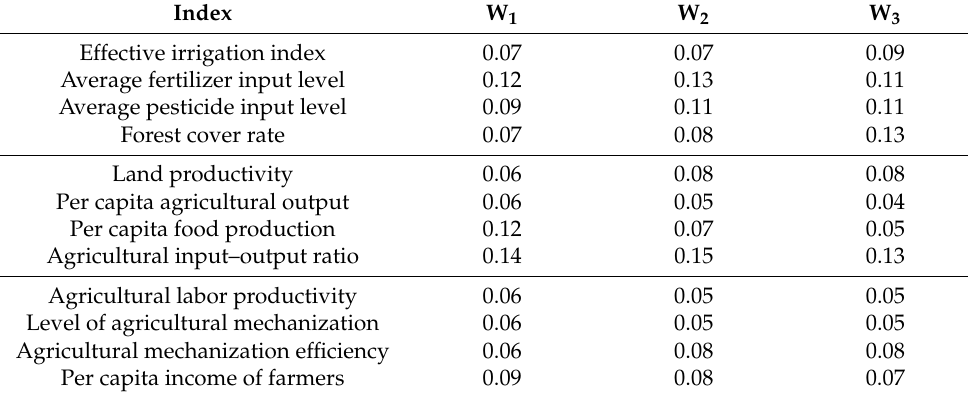
Table 3. Index weights of Shiyan City, Xiangyang City, and Suizhou City.